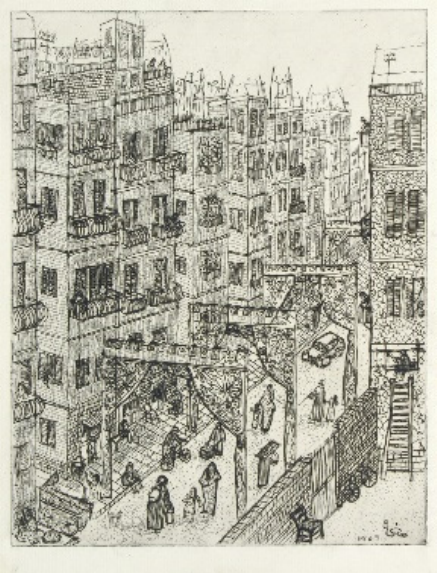
Figure 13. Menhat Helmy, Bulaq on the Prophet’s Birthday (1956). Etching. Courtesy of estate of Menhat Helmy.